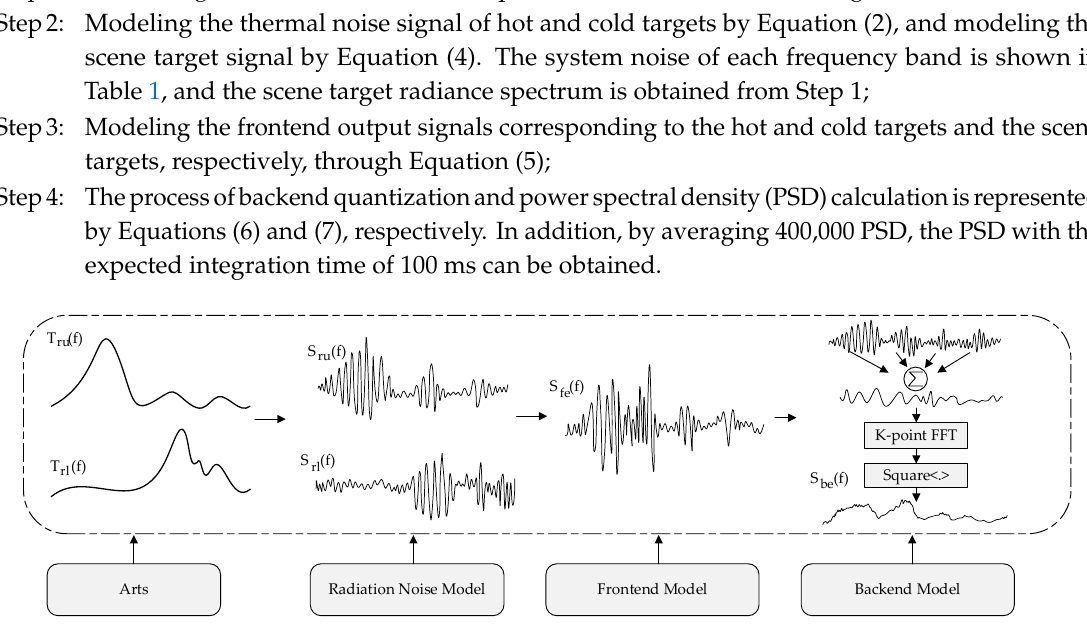
Figure 11. Simulation modeling steps.